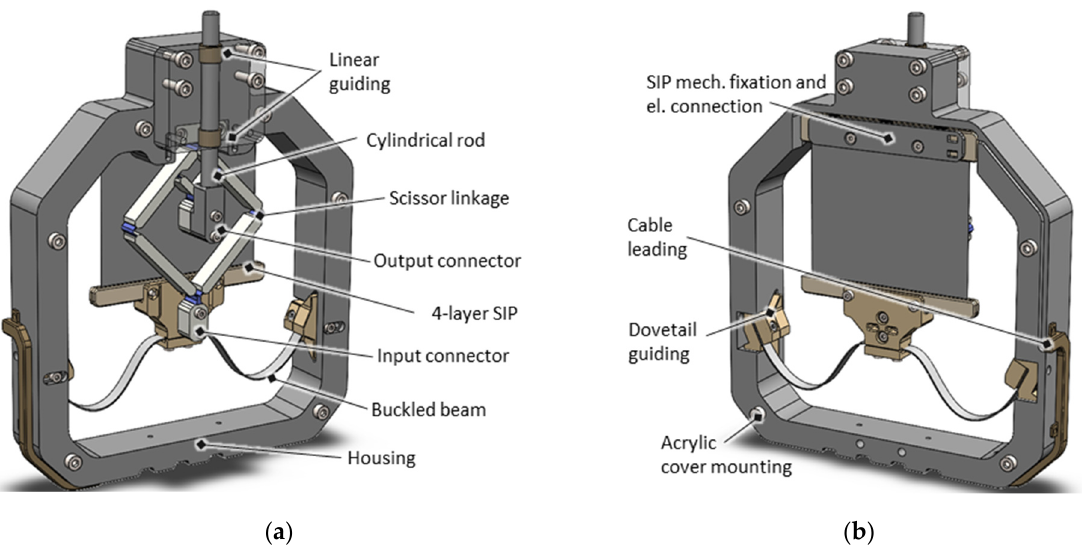
Figure 8. CAD of the SIP system assembly with ( a ) view on the scissor linkage transmission side, and ( b ) view to the SIP-NBS side.